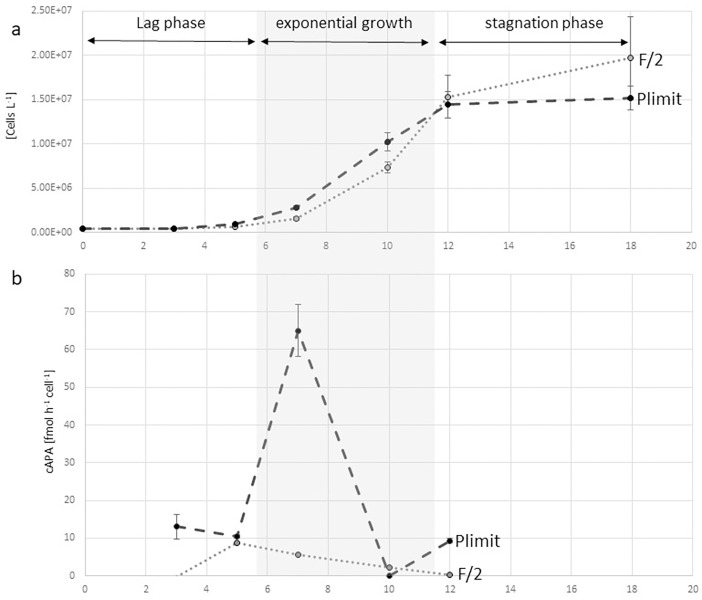
Dynamics of cellular alkaline phosphatase activity (APA) during batch cultures of C. peruvianus cells in F/2 medium and in P-limit medium.(a) Growth curves (average cell numbers with standard deviations as error bars) in F/2 medium (dotted line) and in P-limit medium (dashed line). (b) Cellular APA in F/2 medium (dotted line) and in P-limit medium (dashed line). Note the sharp in increase at the end of the lag phase and the steep reduction of cellular APA during the exponential growth phase.